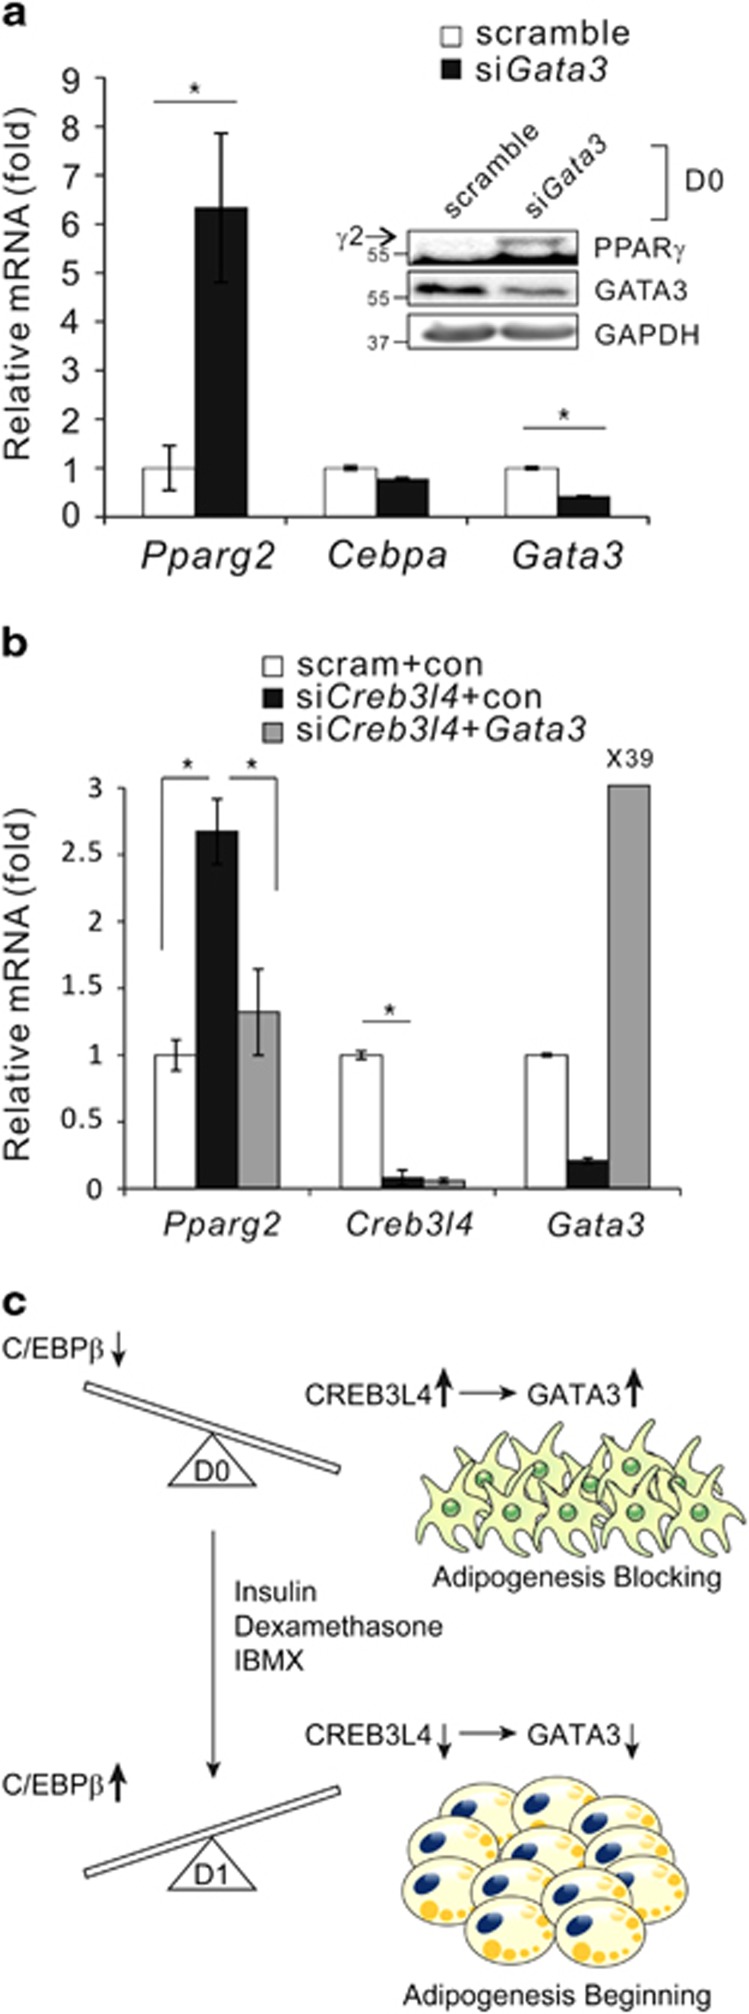
GATA3 is another mediator of CREB3L4 downregulating the expression of PPARγ2. (a) Expression of PPARγ2 and C/EBPα in 3T3-L1 cells expressing siGata3, at D0. (b) The mRNA levels of Pparg2, Creb3l4, and Gata3 in 3T3-L1 cells transfected with siCreb3l4 and a CMV-mGata3-FL expression vector, at D0. Values are expressed as mean±S.E.M., n=3, *P<0.05. (c) In preadipocytes, CREB3L4 acts as a negative regulator of adipogenesis by both regulating the stability of C/EBPβ protein and increasing GATA3 expression. After induction of differentiation by DMI (DMI: 0.5 mM 3-isobutyl-1-methylzanthine [IBMX; M], 1 μM dexamethasone [D], and 1 μg/ml of insulin [I]), Creb3l4 and Gata3 expression is decreased, and increased C/EBPβ levels initiate adipogenesis by increasing the expression of PPARγ2 and C/EBPα. Suppression of Creb3l4 in preadipocytes induces adipogenesis by increasing PPARγ2 expression